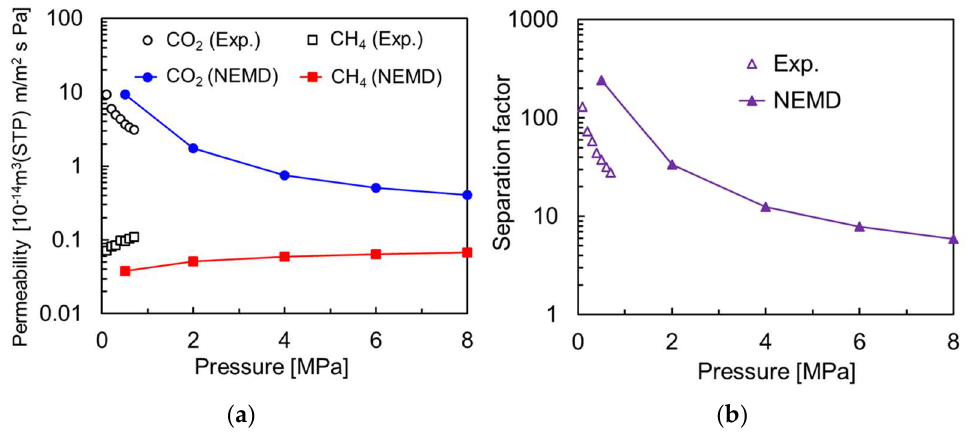
Figure 4. NEMD results on the perfectly crystalline model of zeolite membrane at different pressure conditions. ( a ) Permeability, ( b ) separation factor.